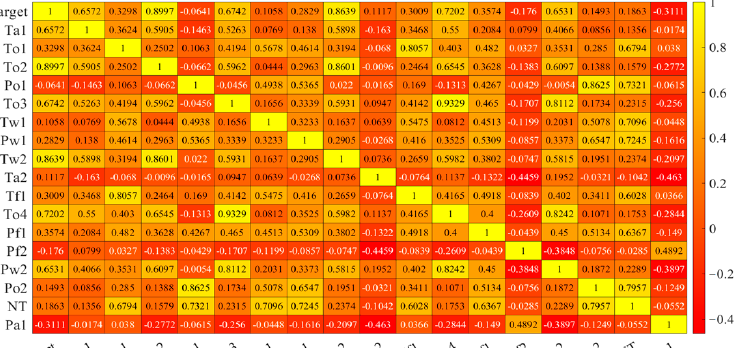
Figure 4. Heat map of the correlation matrix.